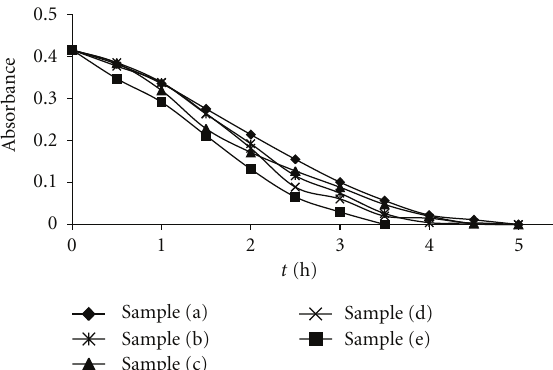
Figure 5: Decolorization of MO solution under UV